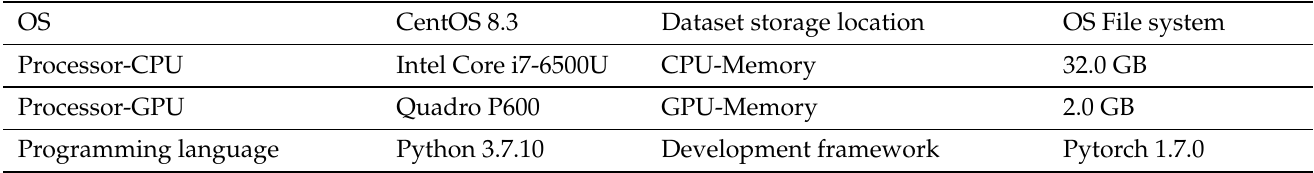
Table 1. The computational